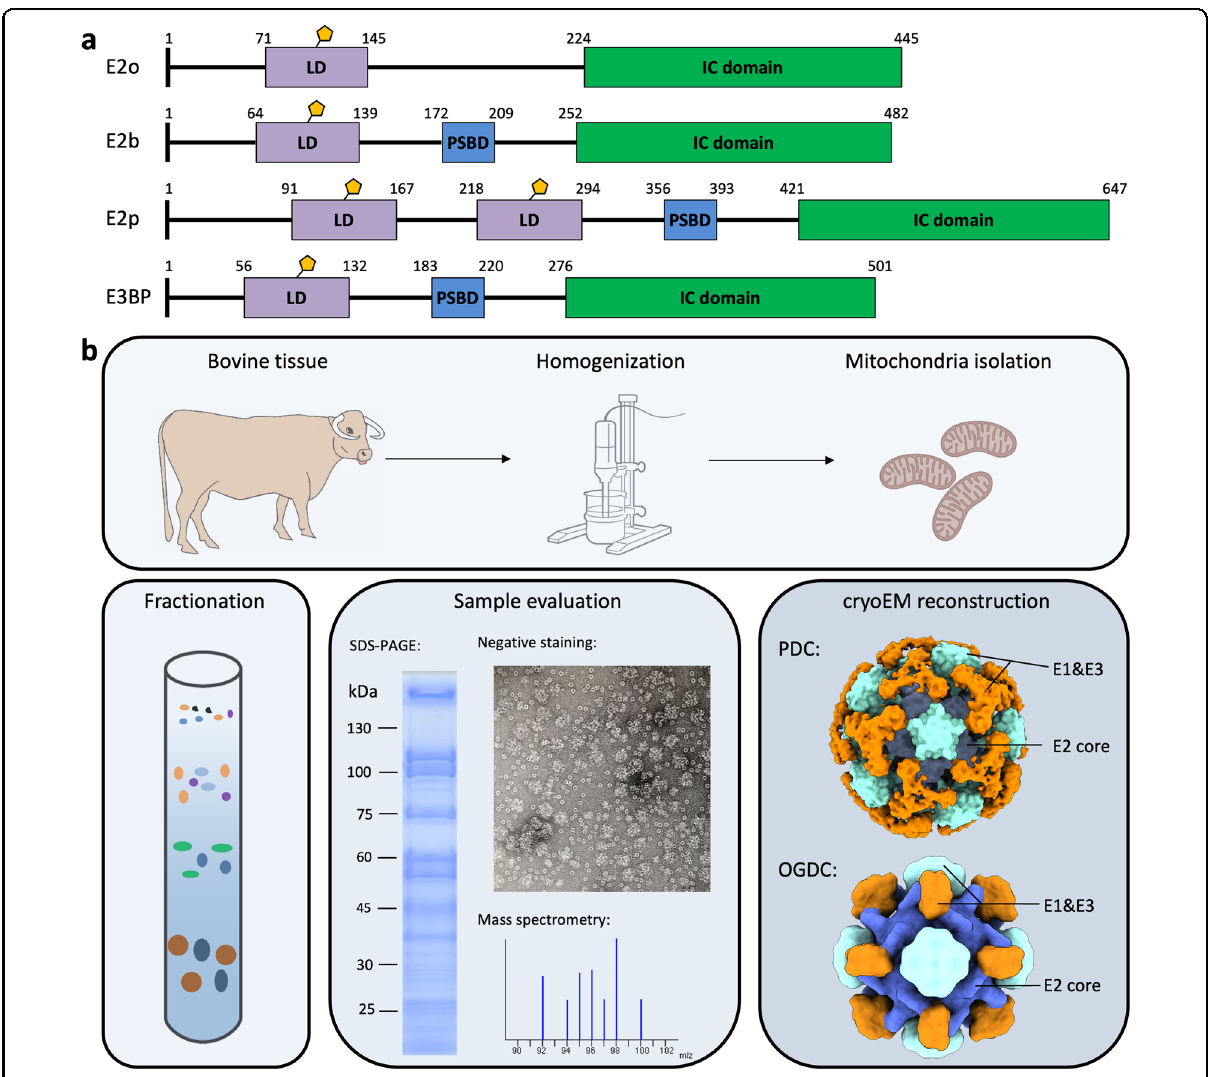
Fig. 1 Preparation of bovine OGDC and PDC from native tissue lysate. a Organization of E2 and E3BP domains. b Work fl ow for extraction of PDC and OGDC from bovine tissue lysate. Bovine kidney was homogenized to isolate mitochondria. Mitochondrial lysates were then fractionated by sucrose gradient. Samples were evaluated for α -keto acid dehydrogenase complex by SDS-PAGE, negative stain, and mass spectrometry. Cryo-EM reconstruction of these samples yielded icosahedral and cubic cores surrounded by peripheral